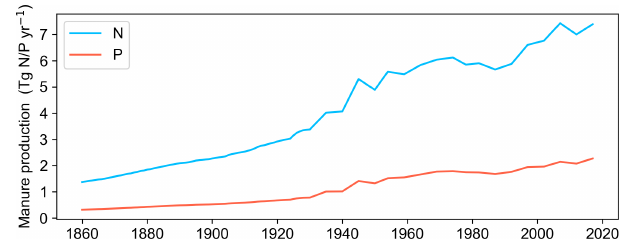
Figure 2. Trend and variation in total manure N and P production in the contiguous US from 1860 to